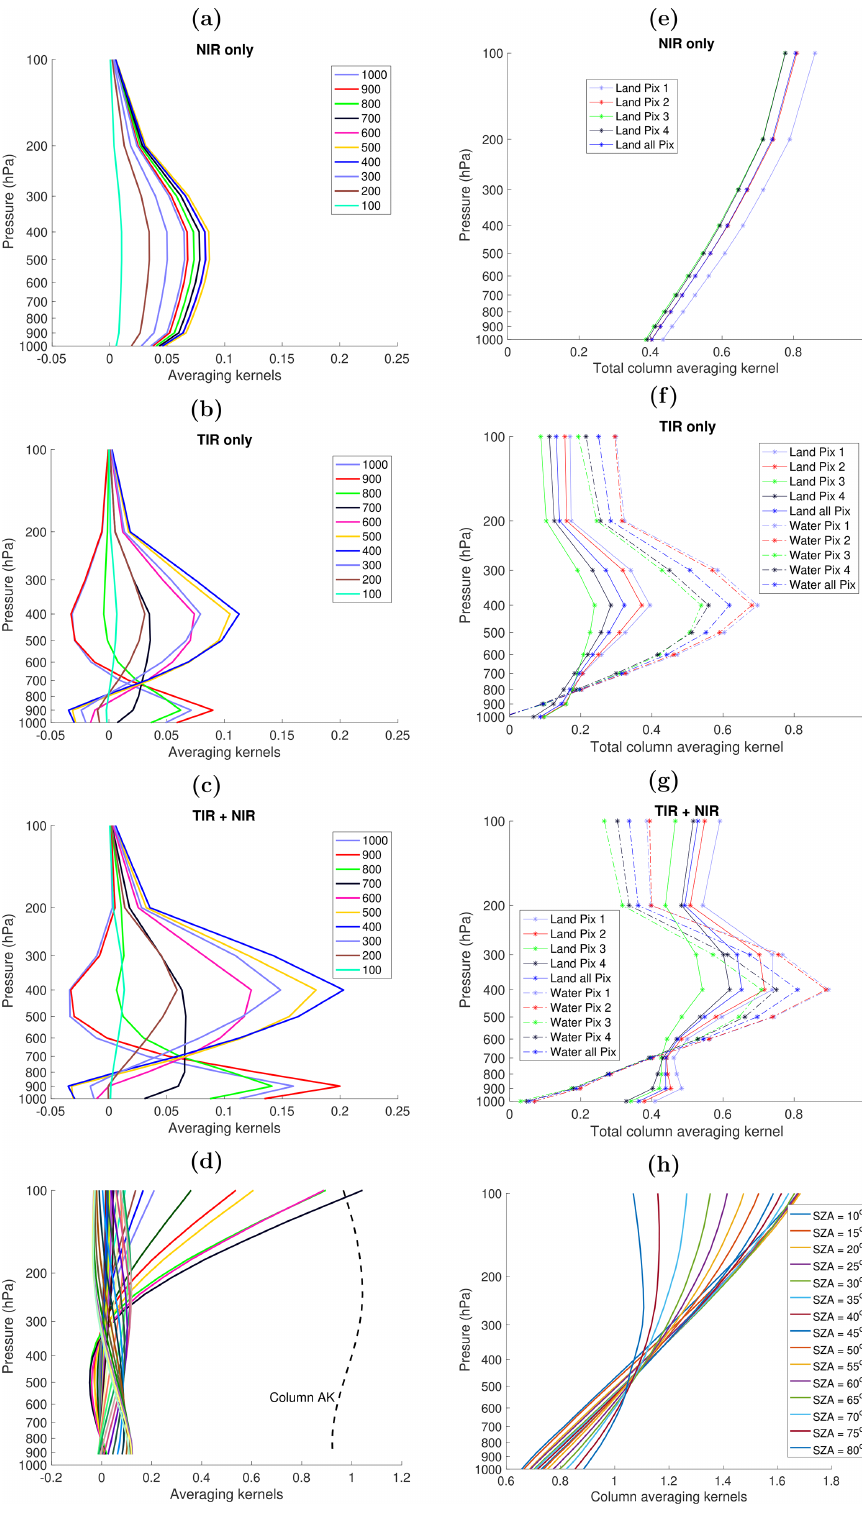
Figure 6. Mean MOPITT retrieval averaging kernels between 2010 and 2019 within a 110km radius from Eureka over land for all pixels: (a) NIR only, (b) TIR only, and (c) multi-spectral TIR+NIR. MOPITT total column averaging kernel for each pixel over land and water for (e) NIR only, (f) TIR only, and (g) multi-spectral TIR+NIR. NDACC FTIR averaging kernels and TCCON FTIR column averaging kernels for Eureka, averaged over 2006–2019 and 2010–2019, are in panels (d) and (h) , respectively. https://doi.org/10.5194/amt-15-6837-2022 Atmos. Meas. Tech., 15, 6837–6863,